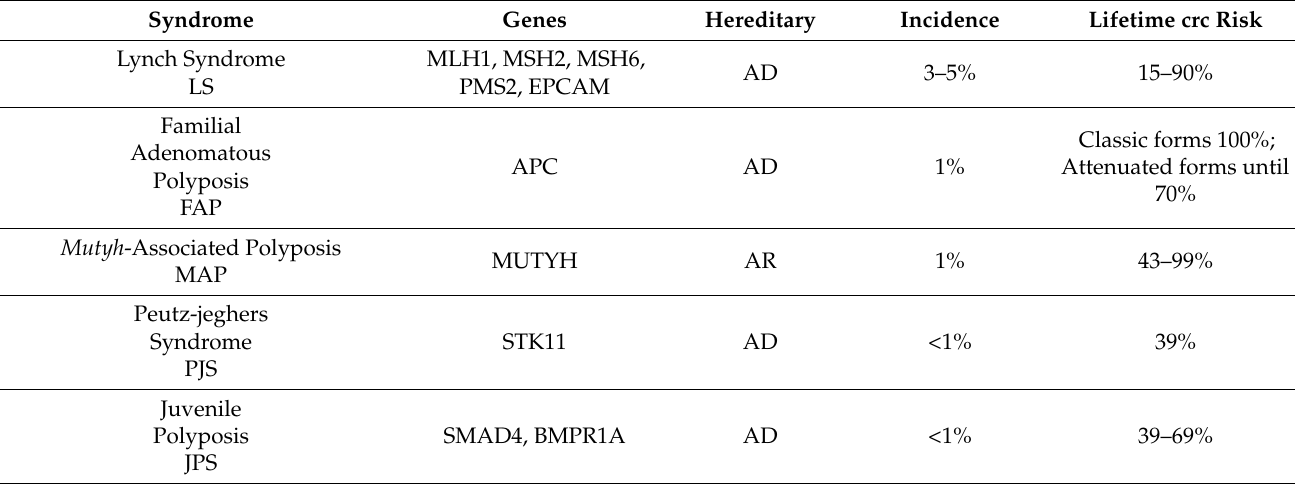
Table 1. Hereditary syndromes with known genetic predisposition to